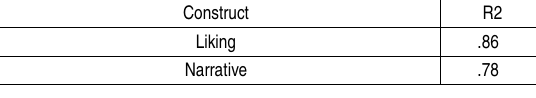
Table 4. Explained proportion of variance (n = 550)